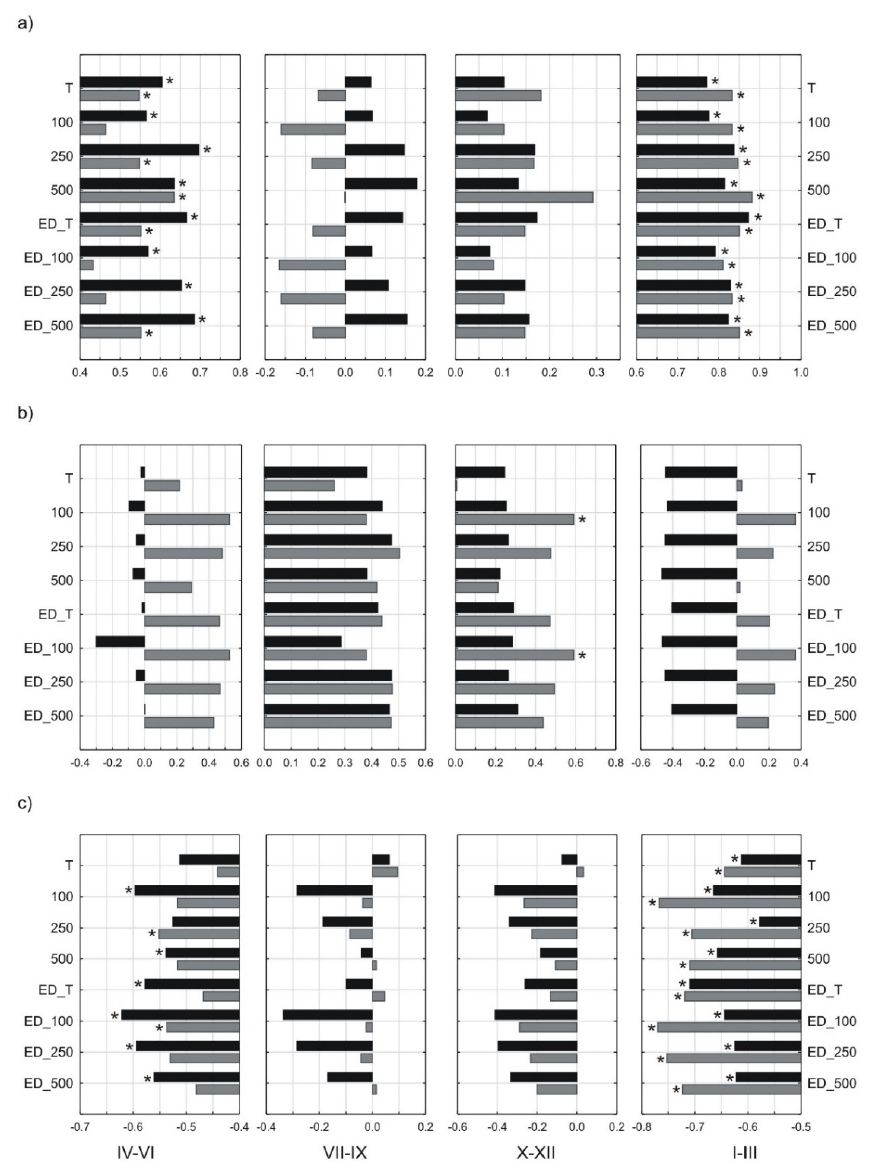
Figure 5. Correlation coefficients between N-NO 3 concentration in certain seasons and different land cover metrics calculated for agricultural lands ( a ), meadows ( b ), and forests ( c ) with the use of the CLC 208 and S2GLC datasets, respectively. Abbreviations: T, total catchment area; 100, 250, and 500, width of the buffer zone; ED, metrics computed with the Euclidean distance scaling. The * indicates significant correlation at p =